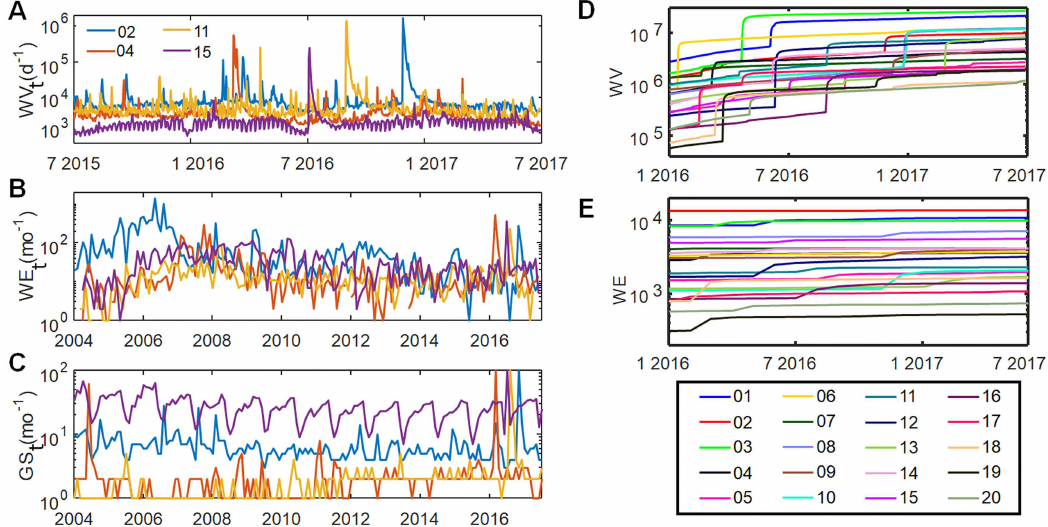
Fig 3. Temporal fluctuation and cumulative values of internet metrics of fame. For four individuals in Table 1, the figures at left show (A) the variation in daily Wikipedia page views ( WV t ) over a two year interval, (B) monthly Wikipedia page edits ( WE t ) over 13 years, (C) monthly Google searches, ( GS ), over 13 years. GS data for each individual are normalized to a maximum value of 100. t t For all 20 individuals in Table 1, the figures at right show (D) cumulative WV and (E) cumulative WE . The legends identify the individuals by their ID in Table